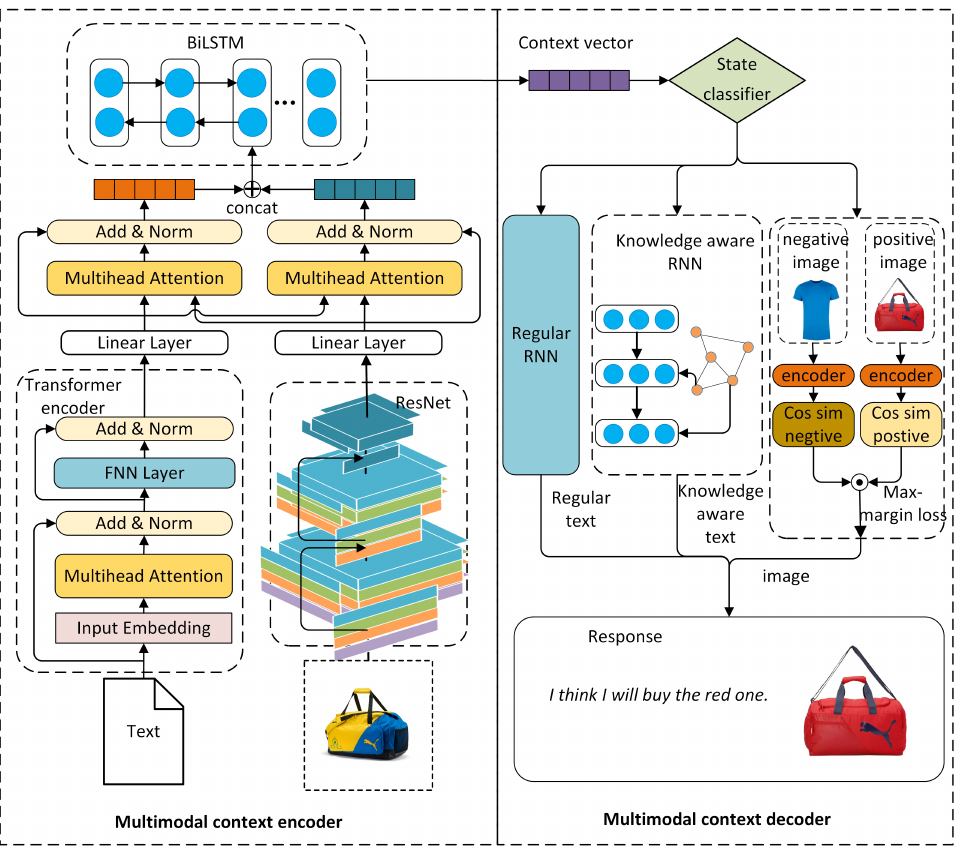
Figure 2. Framework of Transformer-based Mutlimodal Infusion Dialogue